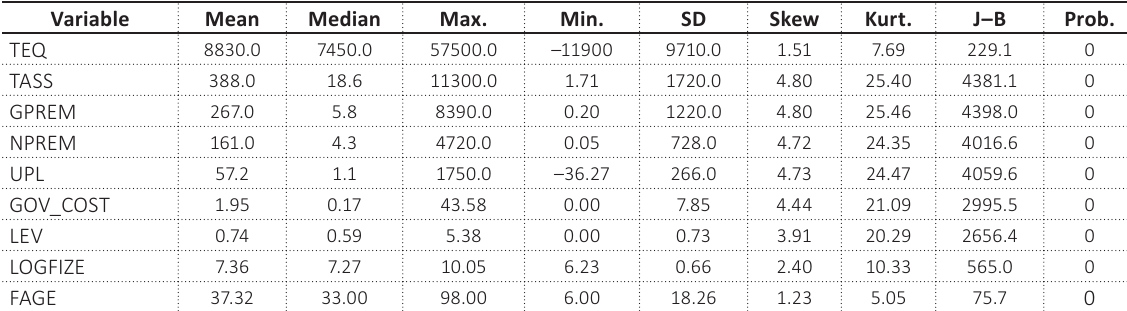
Table 3. Descriptive statistics for Insurance firms